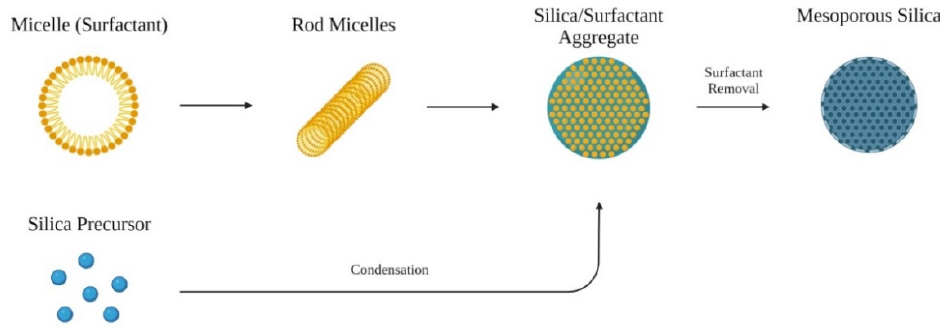
Figure 1. Formation of ordered mesoporous materials from surfactant and silica precursor.